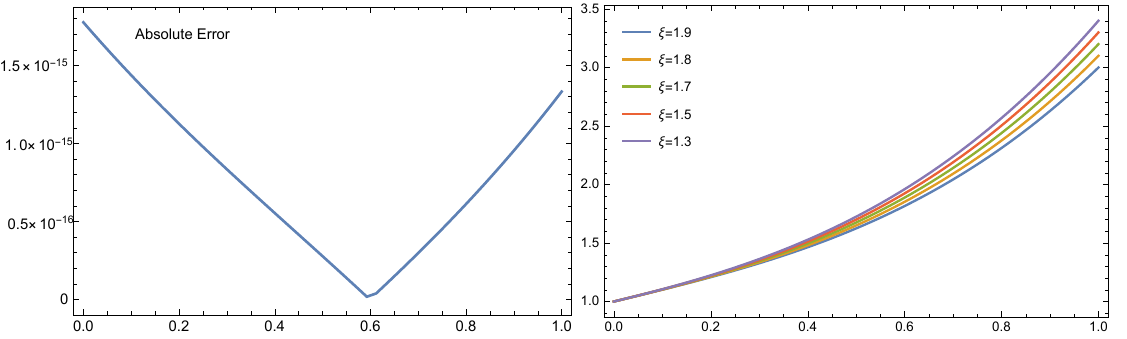
Figure 1. The absolute error ( left ), while ( right ) the numerical solution for different fractional-order cases of ξ for Example 1 with m = 3. Table 1. Approximate solution result comparisons for the methods in [51,52], and the proposed method for Example 1, ζ = 1.5, and m = 3.